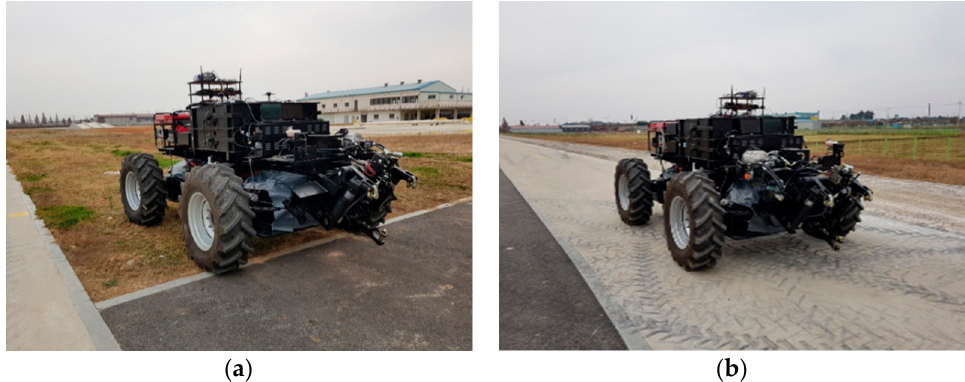
Figure 5. Photos of driving operation of electric AWD tractor under ( a ) off-road and ( b ) on-road conditions.